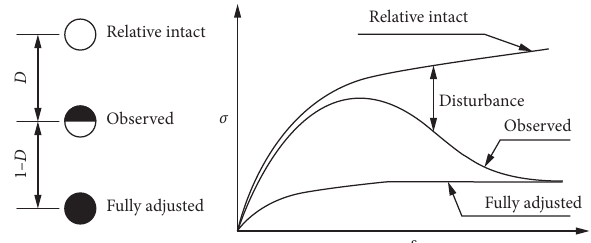
Figure 2: Schematic of stress vs. strain behavior in